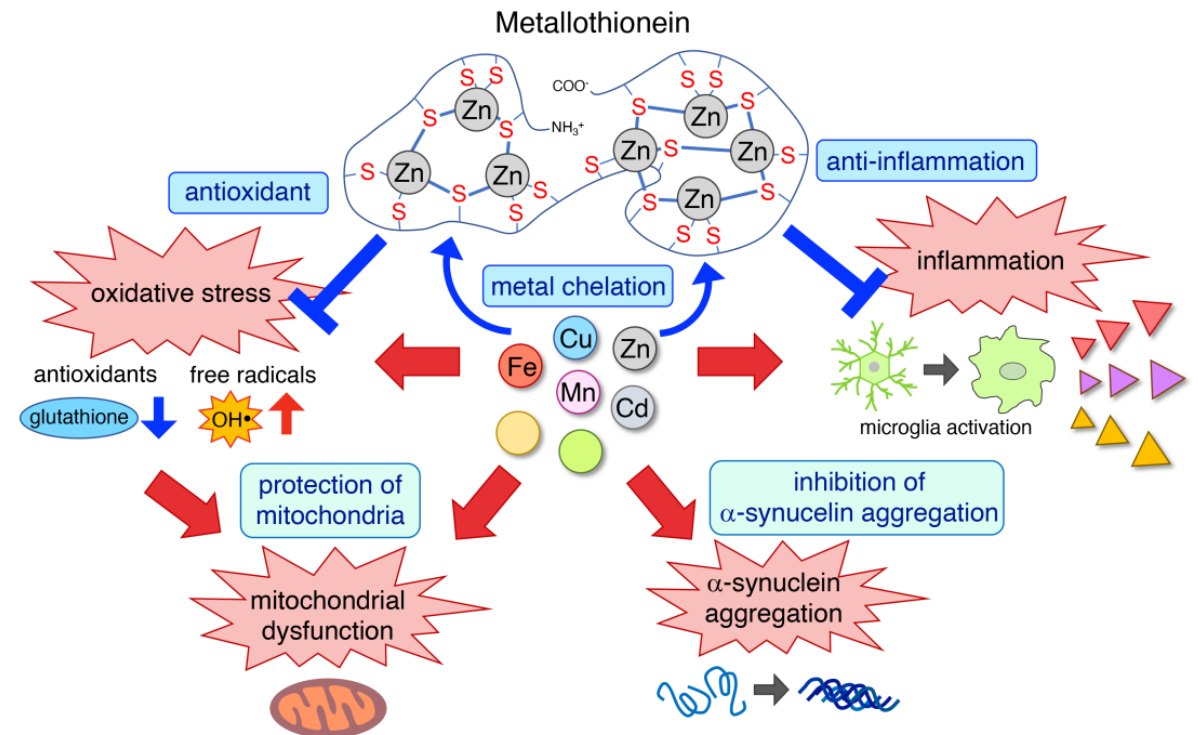
Figure 1. Protective functions of MTs against etiopathogenesis in PD. Heavy metals induce microglial activation, which produces proinflammatory cytokines (indicated by triangles) resulting in neuroinflammation. Metals increase free radicals and decrease antioxidants such as reduced form of glutathione; thus, metals induce oxidative stress and mitochondrial dysfunction. Metals also accelerate α -synuclein aggregation. MTs chelate metals and inhibit metal-induced oxidative stress, inflammation, mitochondrial dysfunction and α -synuclein aggregation. In addition, MTs possess antioxidative properties by scavenging free radicals and exert anti-inflammatory effects by suppression of microglial activation.